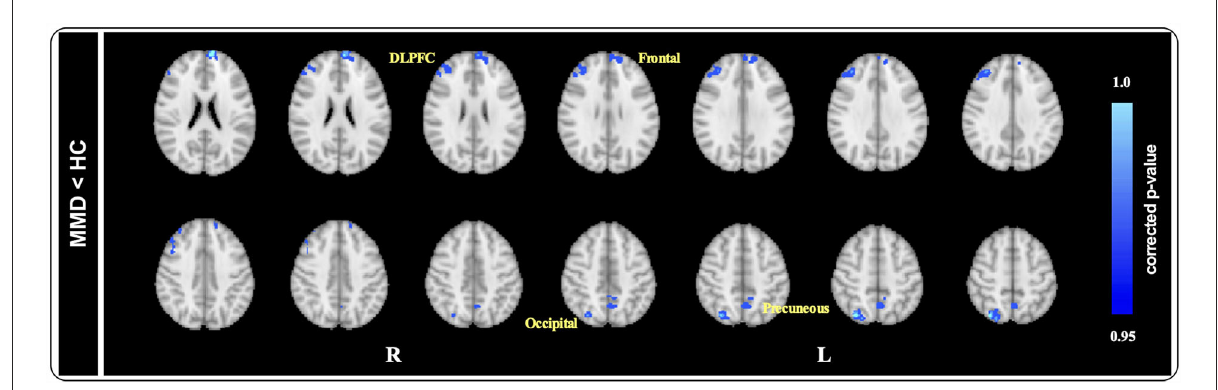
FIGURE3 Voxel-based morphology comparison between MMD and HCs. After controlling the effects of age and gender by adding them as covariates, ACOVA showed the gray matter volume of the DLPFC, frontal cortex, occipital cortex, and precuneus were significantly smaller in MMD patients than in HCs ( p < 0.05, TFCE corrected). DLPFC, dorsolateral prefrontal cortex; HAMD, hamilton depression; MMD, mild-to-moderate depression; HCs, healthy controls.